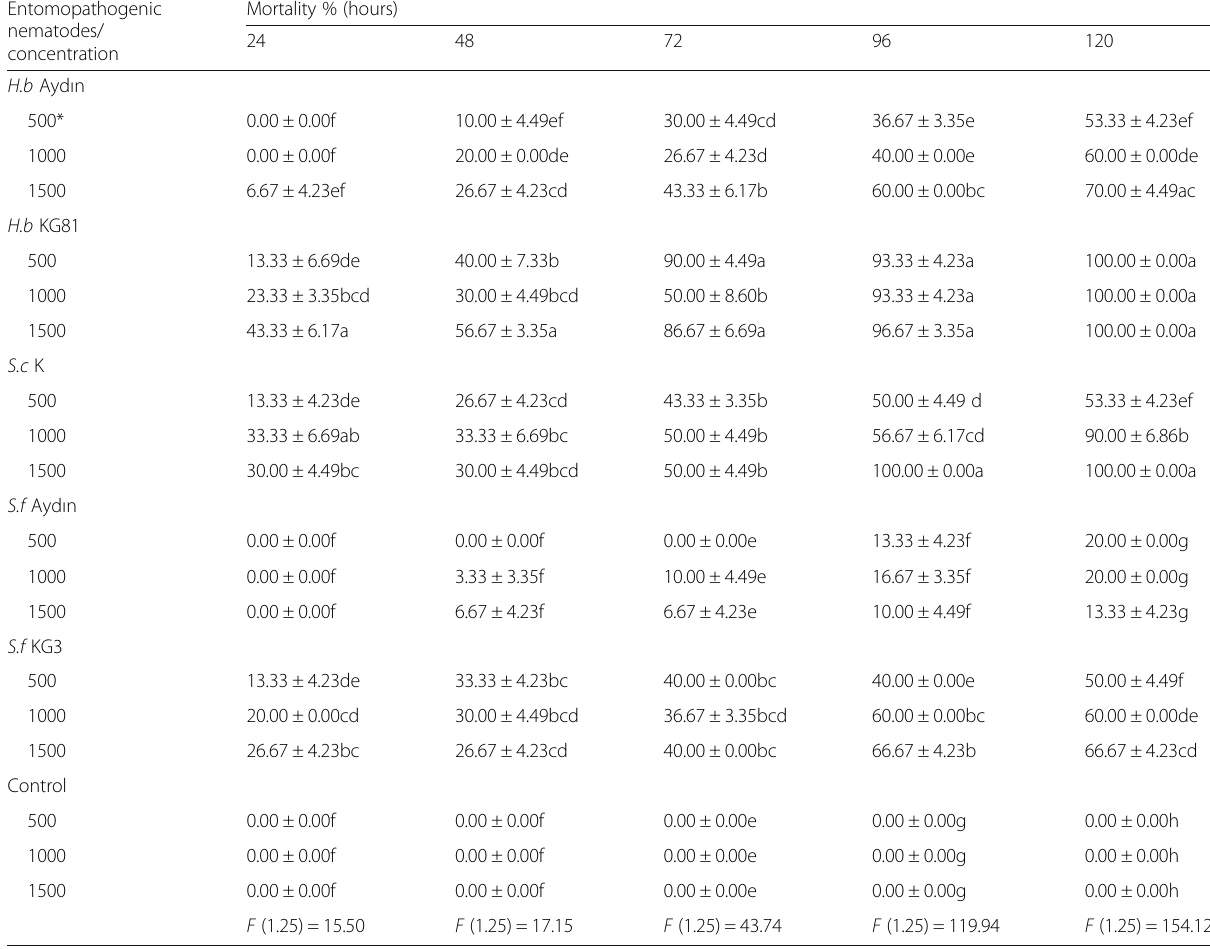
Table 1 Effect of entomopathogenic nematode isolates on mortality of Culex pipiens Entomopathogenic Mortality % nematodes/ concentration